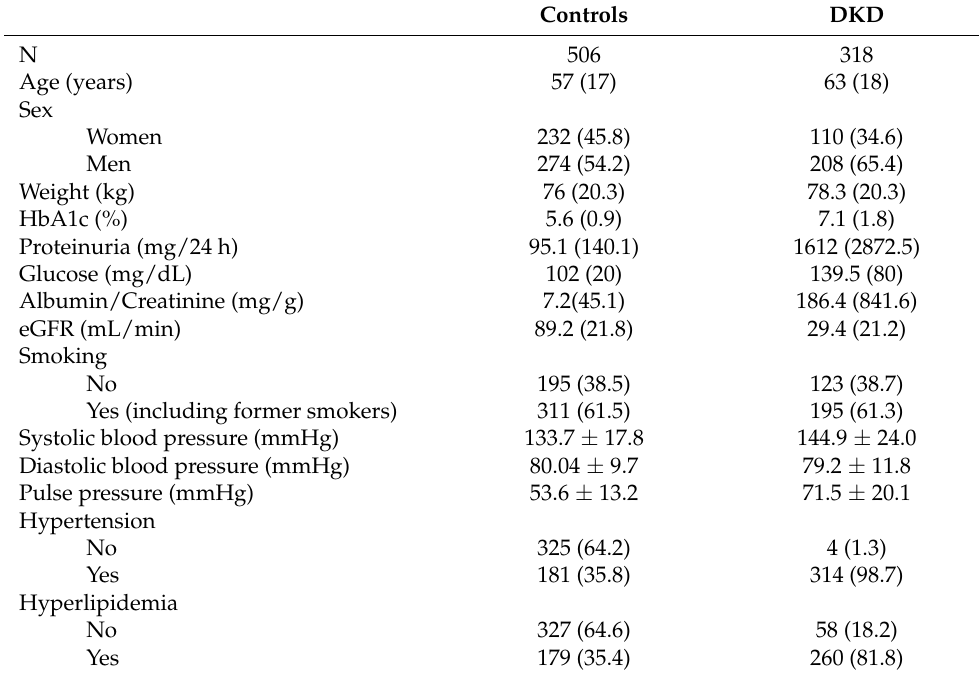
Table 3. Demographic and clinical characteristics of the replication cohort. Data are shown as median (interquartile range) or count (percentages).